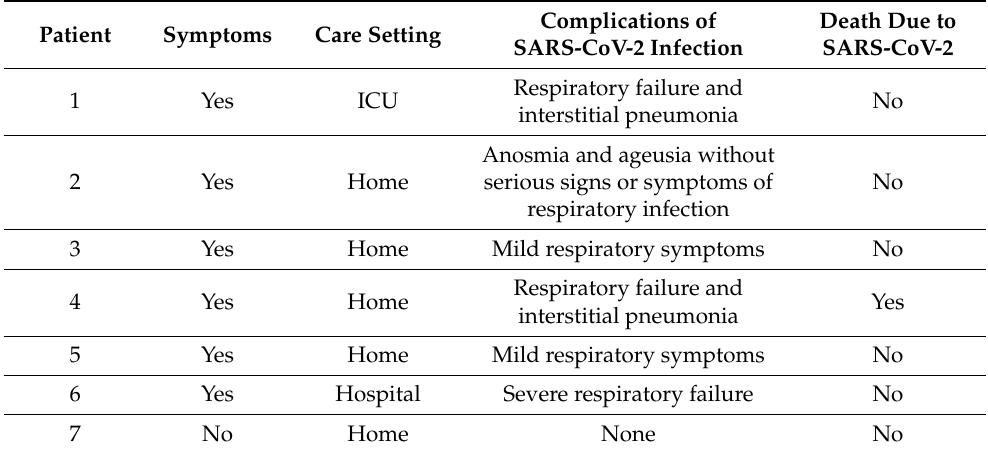
Table 2. Characteristics of SARS-CoV-2 infection in patients included in the analysis (ICU: Intensive care